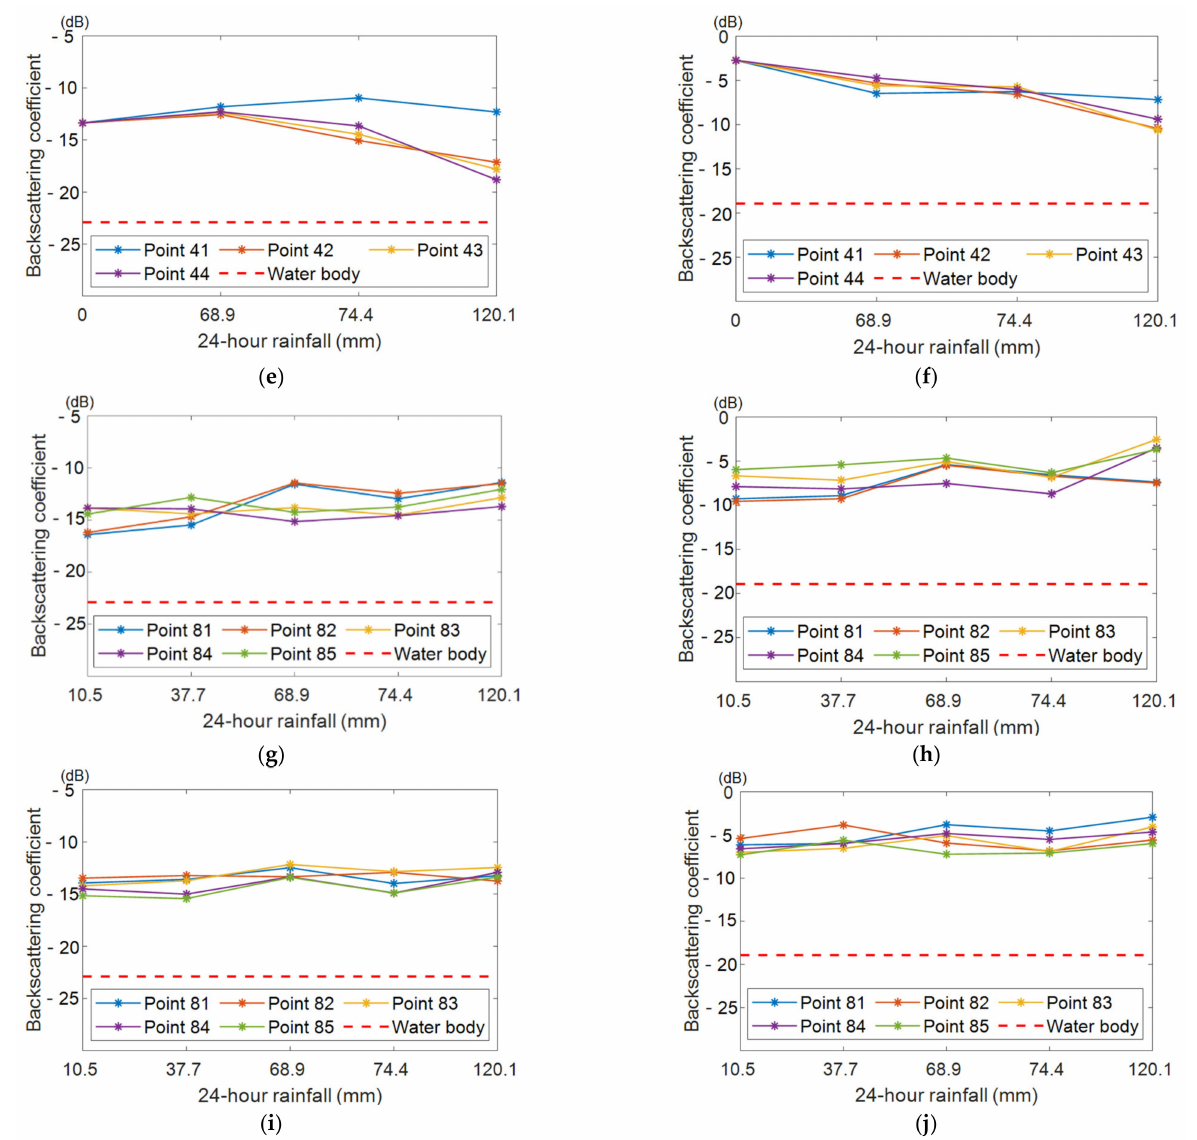
Figure 12. Absolute backscattering coefficient with rainfall: ( a ) Water body—VH; ( b ) Water body—VV; ( c ) Farmland—VH; ( d ) Farmland—VV; ( e ) Farmland with plastic sheds—VH; ( f ) Farmland with plastic sheds—VV; ( g ) Road—VH; ( h ) Road—VV; ( i ) Construction—VH; ( j ) Construction—VV. The red dotted line indicates the backscattering coefficient of an open water body instead of the water body sample